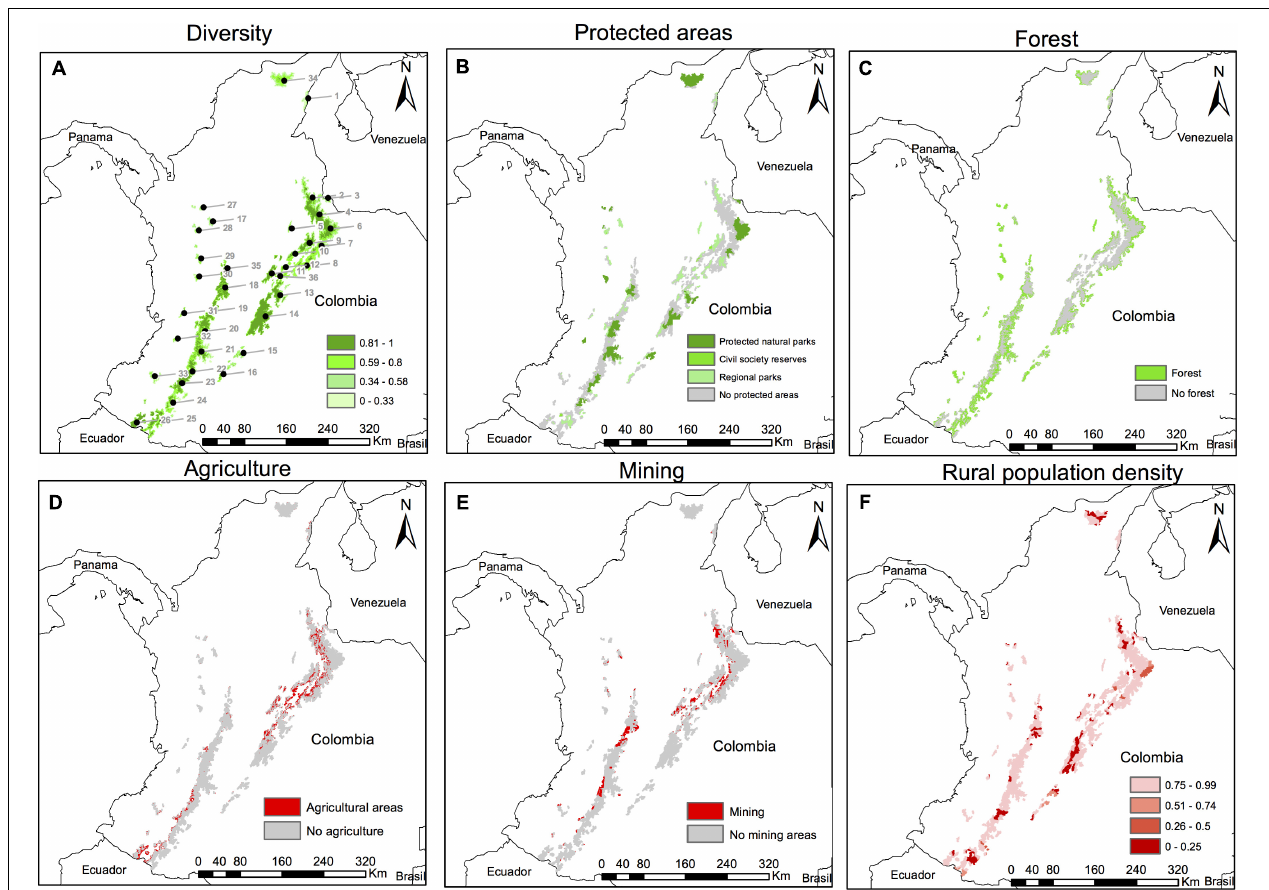
FIGURE 3 | Components of the adaptive capacity across 36 Páramo complexes in the Colombian Andes. Enhancing (A–C) and limiting (D–F) factors of the adaptive capacity are shown in green and red, respectively. Enhancing factors of the biodiversity’s adaptive potential were (A) diversity, (B) protected areas, and (C) forest area around the Páramo, while limiting factors of the plastic response were (D) agriculture, (E) mining and (F) population density. Diversity (A) , which is the number of Espeletia taxa totalized in a 1 km grid based on the occurrence data downloaded from GBIF, and the inverse value of the normalized rural population density (F) were scaled from 0 to 1. A total of 1,050 protected areas (B) were rated as 1, 0.3, 0.1, and 0.1 for National Natural Parks, Civil Society Reserves, Regional Natural Parks and National Protected Forest Reserves, respectively, following (CIAT, 2017). Forest patches (C) around the Páramo complexes (2 km around the tree line, 1 km grid) were recorded as presence points (1 = presence), while agriculture (D) and mining (E) for the period 2010–2012 were marked as null data points (0 = presence) within the study area and in its buffer zone (2 km around the tree line, 1 km grid). Páramo complexes numbers in (A) follow Morales et al. (2007) and Londoño et al. (2014): (1) Perijá, (2) Jurisdicciones-Santurbán, (3) Tamá, (4) Almorzadero, (5) Yariguíes, (6) Cocuy, (7) Pisba, (8) Tota-Bijagual-Mamapacha, (9) Guantiva-Rusia, (10) Iguaque-Merchán, (11) Guerrero, (12) Rabanal y río Bogotá, (13) Chingaza, (14) Cruz Verde-Sumapaz, (15) Los Picachos, (16) Miraflores, (17) Belmira, (18) Nevados, (19) Chilí-Barragán, (20) Las Hermosas, (21) Nevado del Huila-Moras, (22) Guanacas-Puracé-Coconuco, (23) Sotará, (24) Doña Juana-Chimayoy, (25) La Cocha-Patascoy, (26) Chiles-Cumbal, (27) Paramillo, (28) Frontino-Urrao, (29) Citará, (30) Tatamá, (31) Duende, (32) Farallones de Cali, (33) Cerro Plateado, (34) Santa Marta, (35) Sonsón, and (36) Altiplano Cundiboyacense.